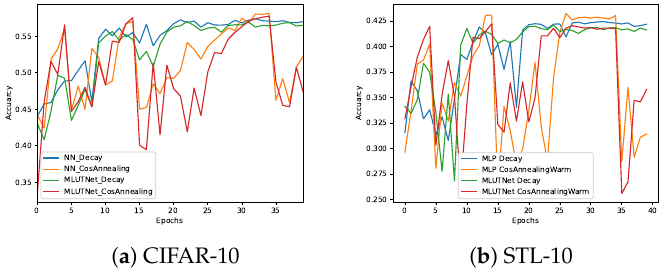
Figure 7. Performance on CIFAR-10 and STL-10 dataset.